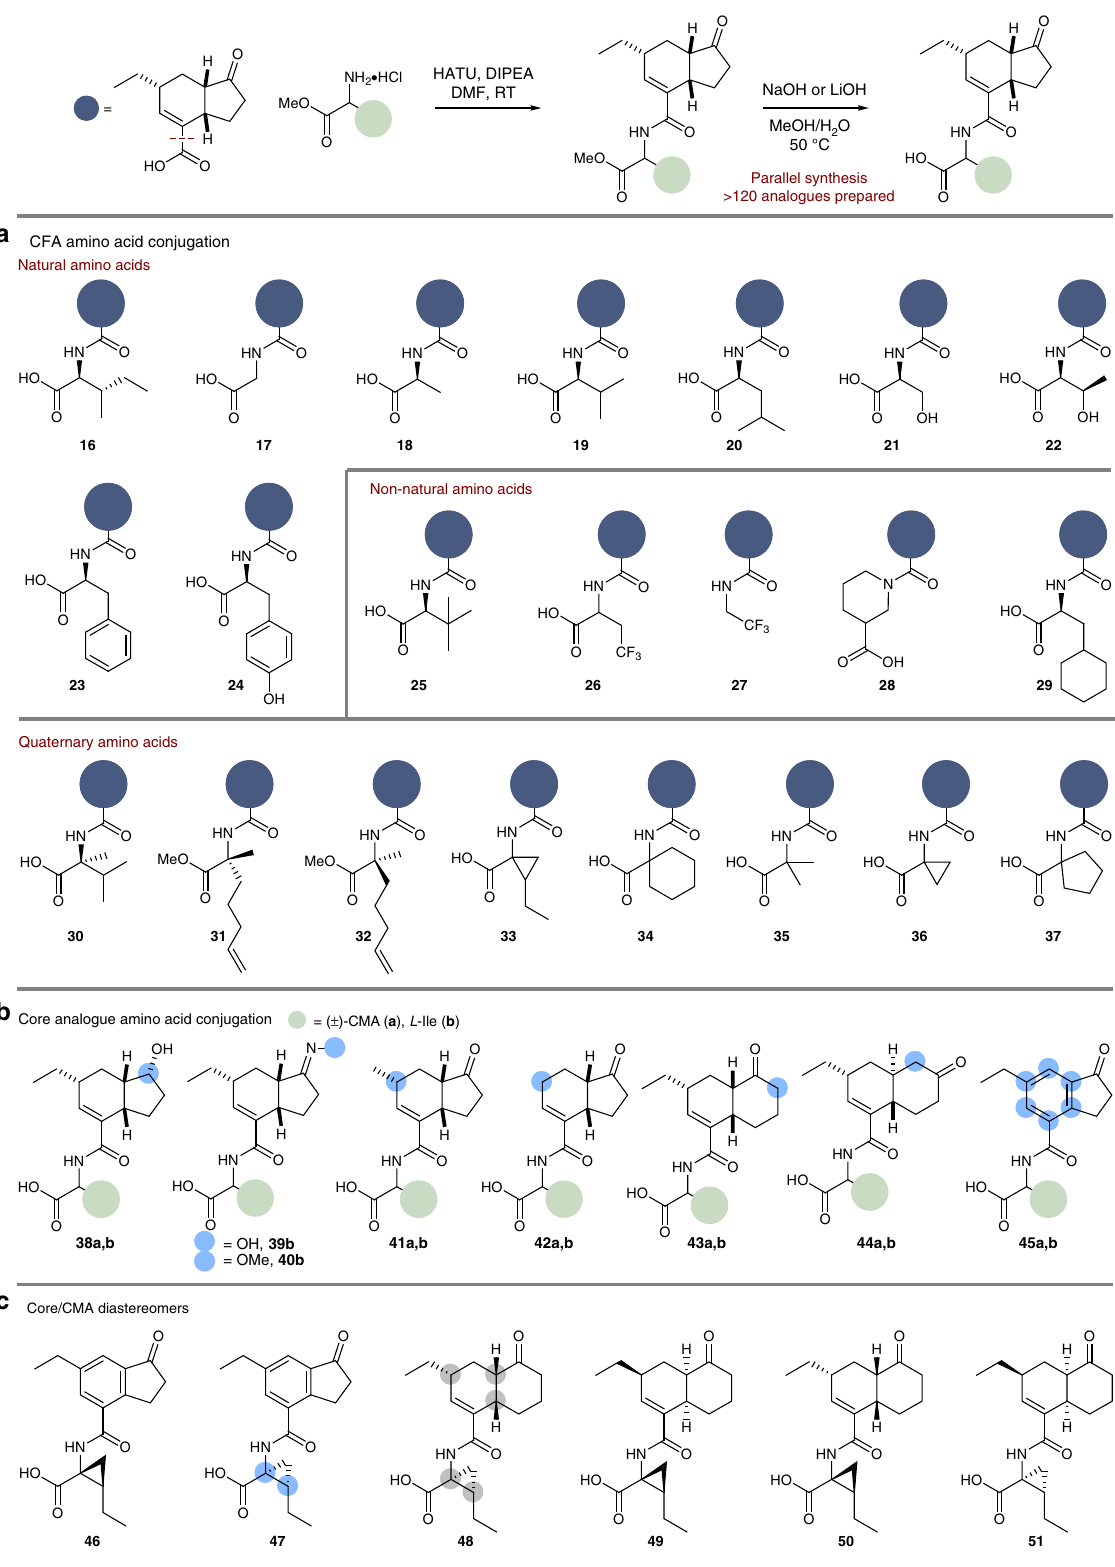
Fig. 3 Representative examples of COR analogue synthesis. a HATU coupling of (±)- 2 and amino acid methyl esters, which were then hydrolysed to afford the free-acids. HATU, 1-[bis(dimethylamino)methylene]-1 H -1,2,3-triazolo[4,5-b]pyridinium 3-oxid hexa fl uorophosphate. b Alternative core coupling to (±)-CMA and L -Ile. c CFA core oxime and core